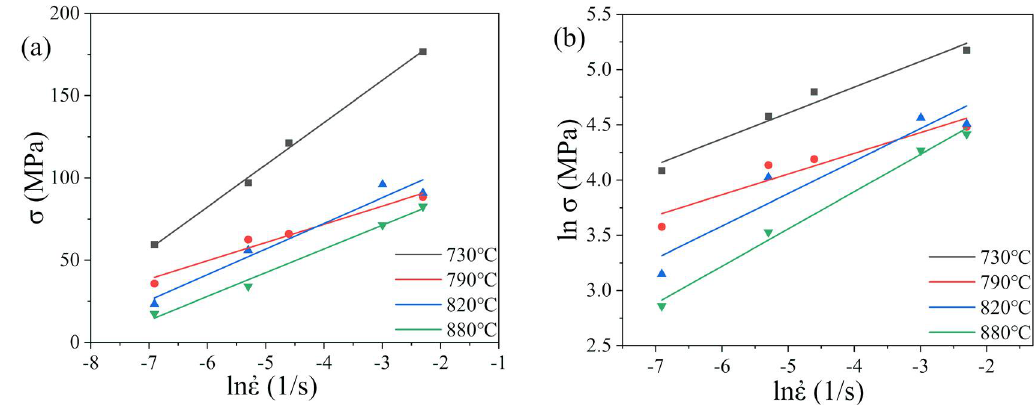
Figure 3. ( a ) Linear fitting of σ –ln έ ; ( b ) linear fitting of ln σ –ln